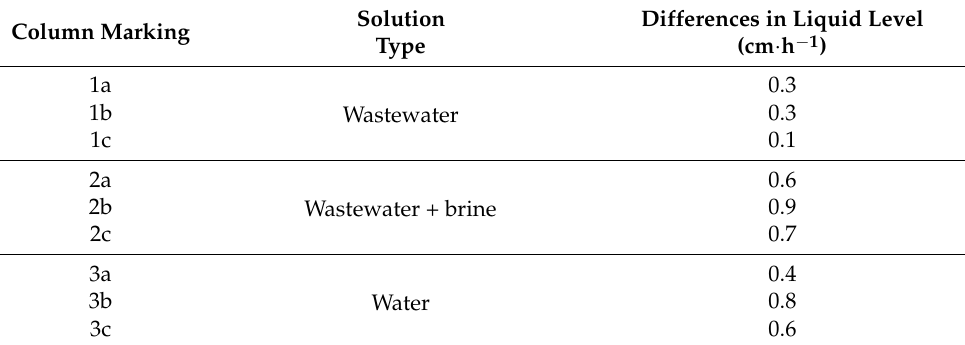
Table 1. Summary of water level differences during hydraulic conductivity testing.